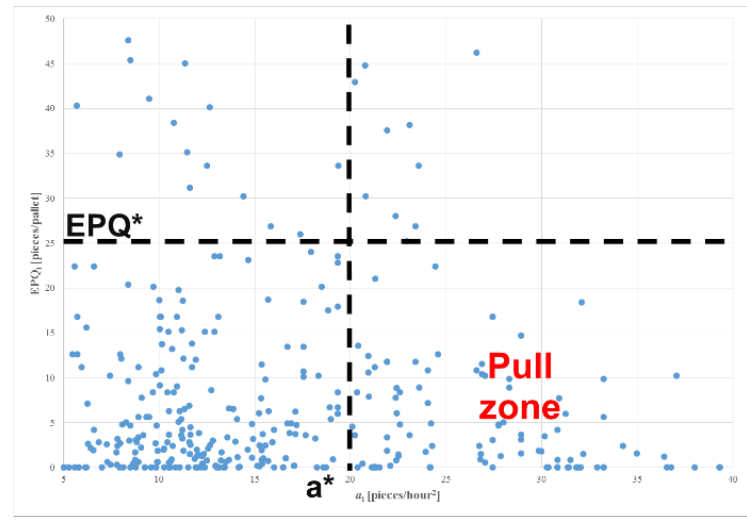
Figure 7. Case study 𝑎